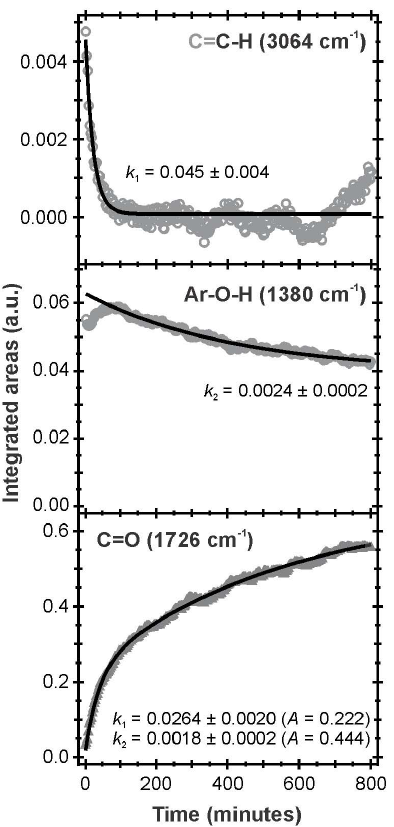
Fig. 7. Reaction kinetics for the ozonolysis of NaCl-adsorbed isoeugenol at 180ppb O 3 depicting (top) rapid consumption of the alkene side chain, (middle) slower decay of the aromatic ring, and (bottom) product carbonyl formation, which required a double- exponential function with rate constants consistent with competitive alkene side-chain vs. methoxyphenol